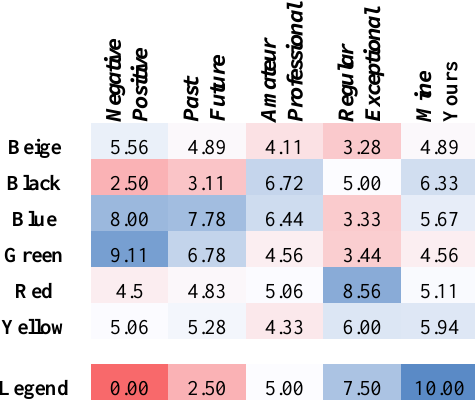
Table 2. Test 1 results, mean of the 18 answers Beige had an association with the word regular . Black resulted in tending towards past more than future but still with people on both extremes. It also had minor match with professional and yours . Blue had other three lighter associations with the word future, professional and regular but still with a high range.